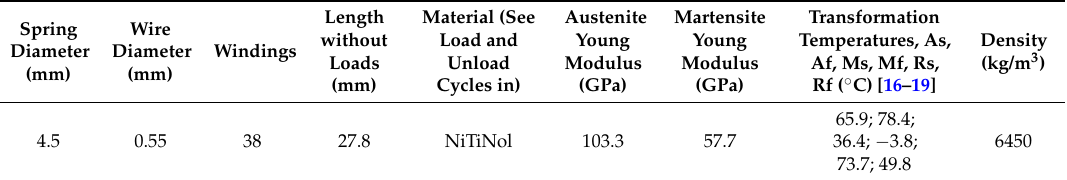
Table 2. Characteristic of the shape memory alloys (SMA) springs.